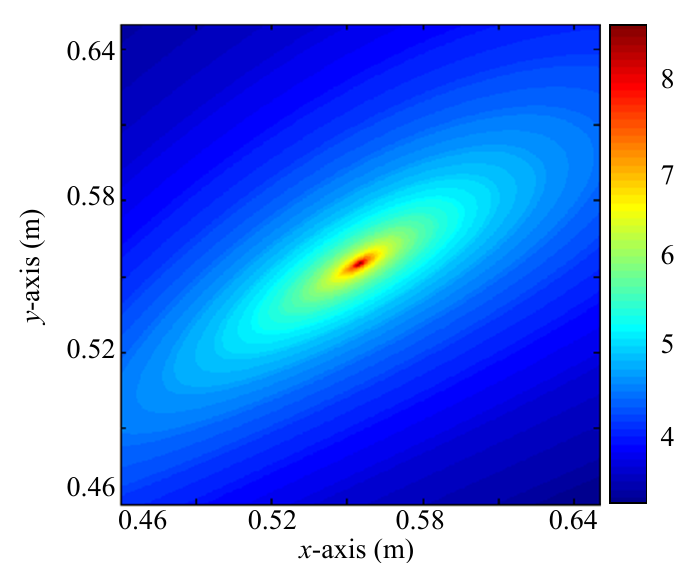
Figure 3. The received signal.